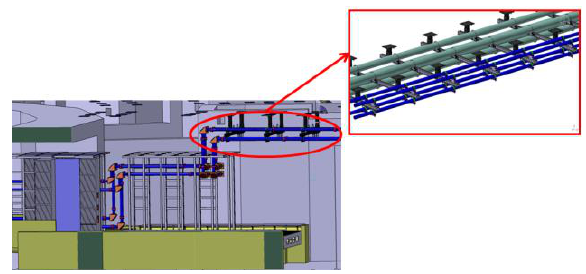
Fig. 8. Ex-Port Plug transmission lines layout and zoon into the waveguide supports attached to the ceiling of the tokamak building